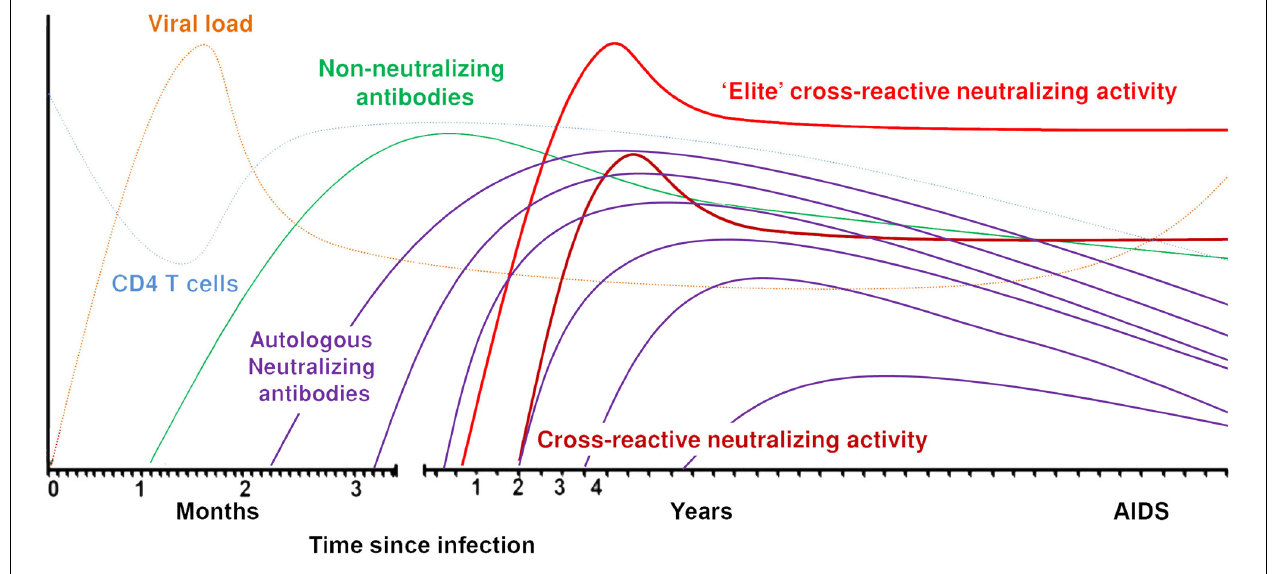
FIGURE 1 | Sequentially elicited antibodies to HIV-1 envelope over the course of the infection.